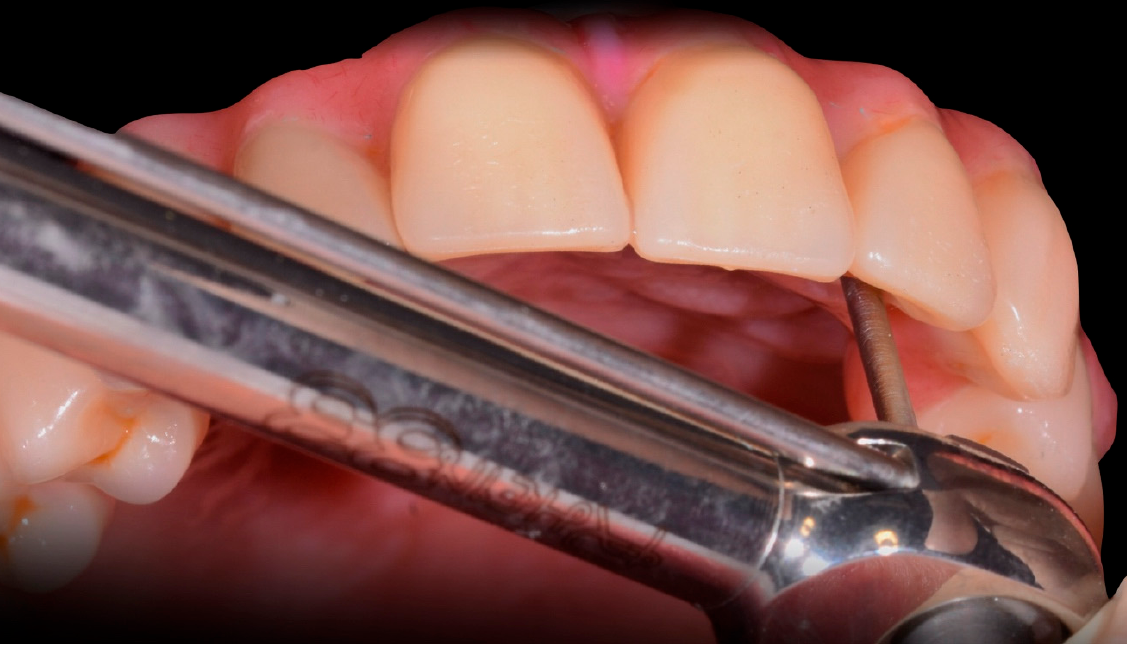
Figure 18. Torque wrench to mount the prosthesis.